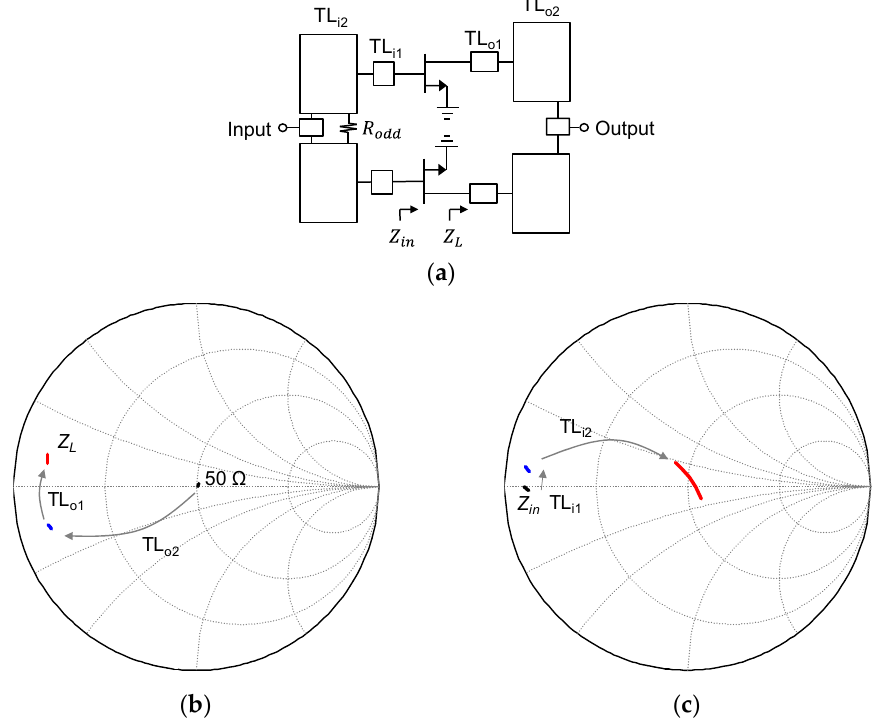
Figure 3. Design of final stage (two 100 μ m-wide HEMTs in parallel). ( a ) Circuit schematic. Impedance trajectories of ( b ) output matching and ( c ) input matching networks from 88 to 92 GHz.